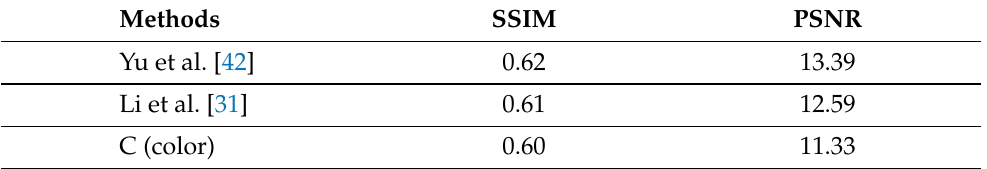
Table 7. Comparison of the SSIM and PSNR indexes on twenty synthetic nighttime images.